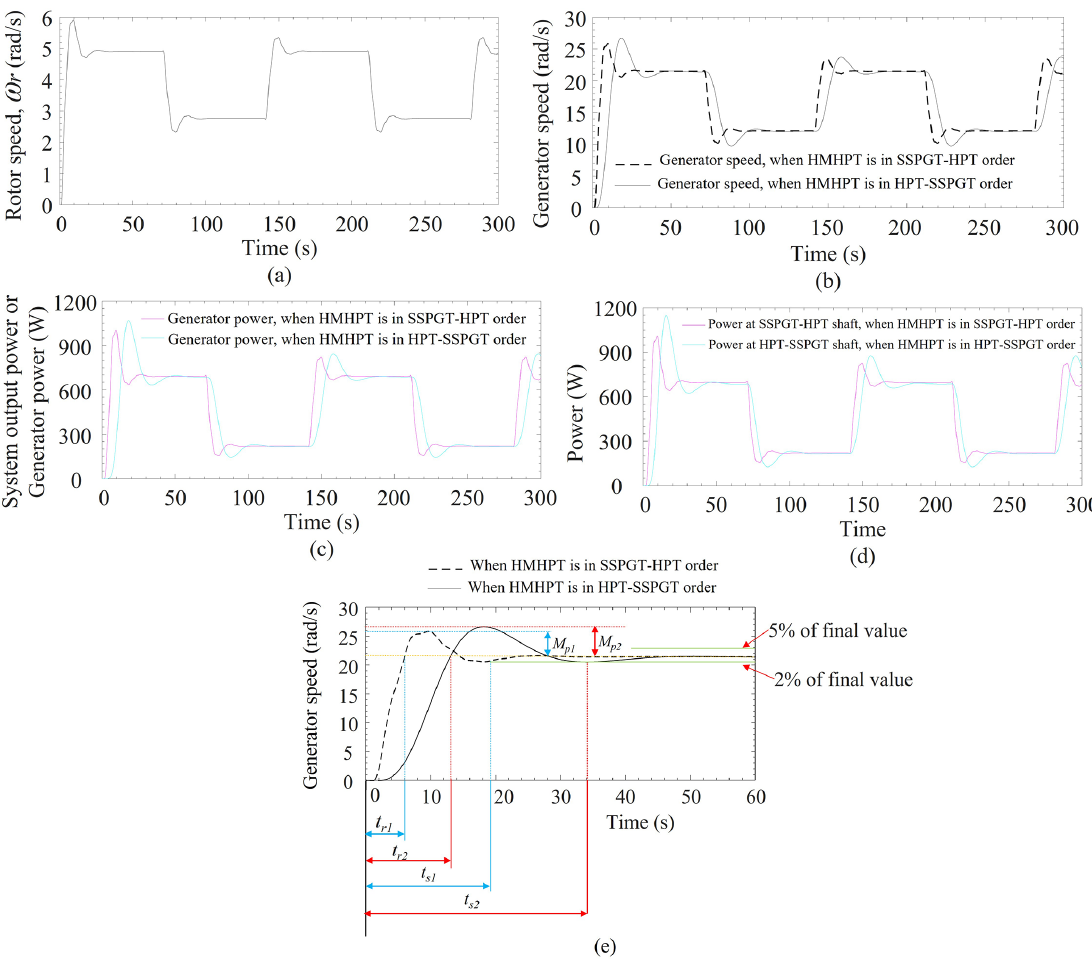
Figure 7. Responses when order of the SSPGT and the HPT are swapped. (a) Rotor speed. (b) Generator speed comparison between SSPGT–HPT and HPT–SSPGT-based HMHPT. (c) Output shaft power, i.e., generator shaft power comparison between SSPGT–HPT and HPT–SSPGT-based HMHPT. (d) Intermediate shaft power comparison between SSPGT–HPT and HPT–SSPGT-based HMHPT. (e) Transient response analysis between SSPGT–HPT and HPT–SSPGT-based